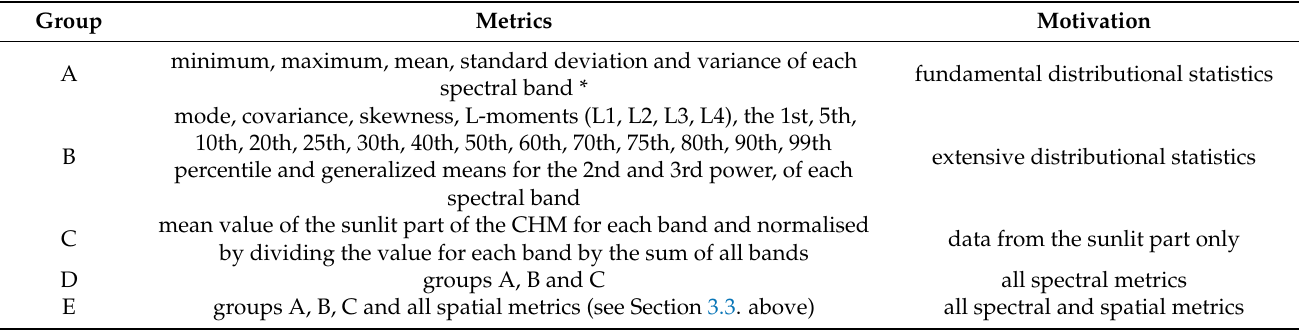
Table 2. Metrics used in the study divided into five different groups with associated motivation for each group. Group Metrics Motivation minimum, maximum, mean, standard deviation and variance of each A fundamental distributional statistics spectral band * mode, covariance, skewness, L-moments (L1, L2, L3, L4), the 1st, 5th, 10th, 20th, 25th, 30th, 40th, 50th, 60th, 70th, 75th, 80th, 90th, 99th B extensive distributional statistics percentile and generalized means for the 2nd and 3rd power, of each spectral band mean value of the sunlit part of the CHM for each band and normalised C data from the sunlit part only by dividing the value for each band by the sum of all bands D groups A, B and C all spectral metrics E groups A, B, C and all spatial metrics (see Section 3.3. above) all spectral and spatial metrics * Mean, standard deviation and variance were normalised by dividing the value for each band by the sum of all